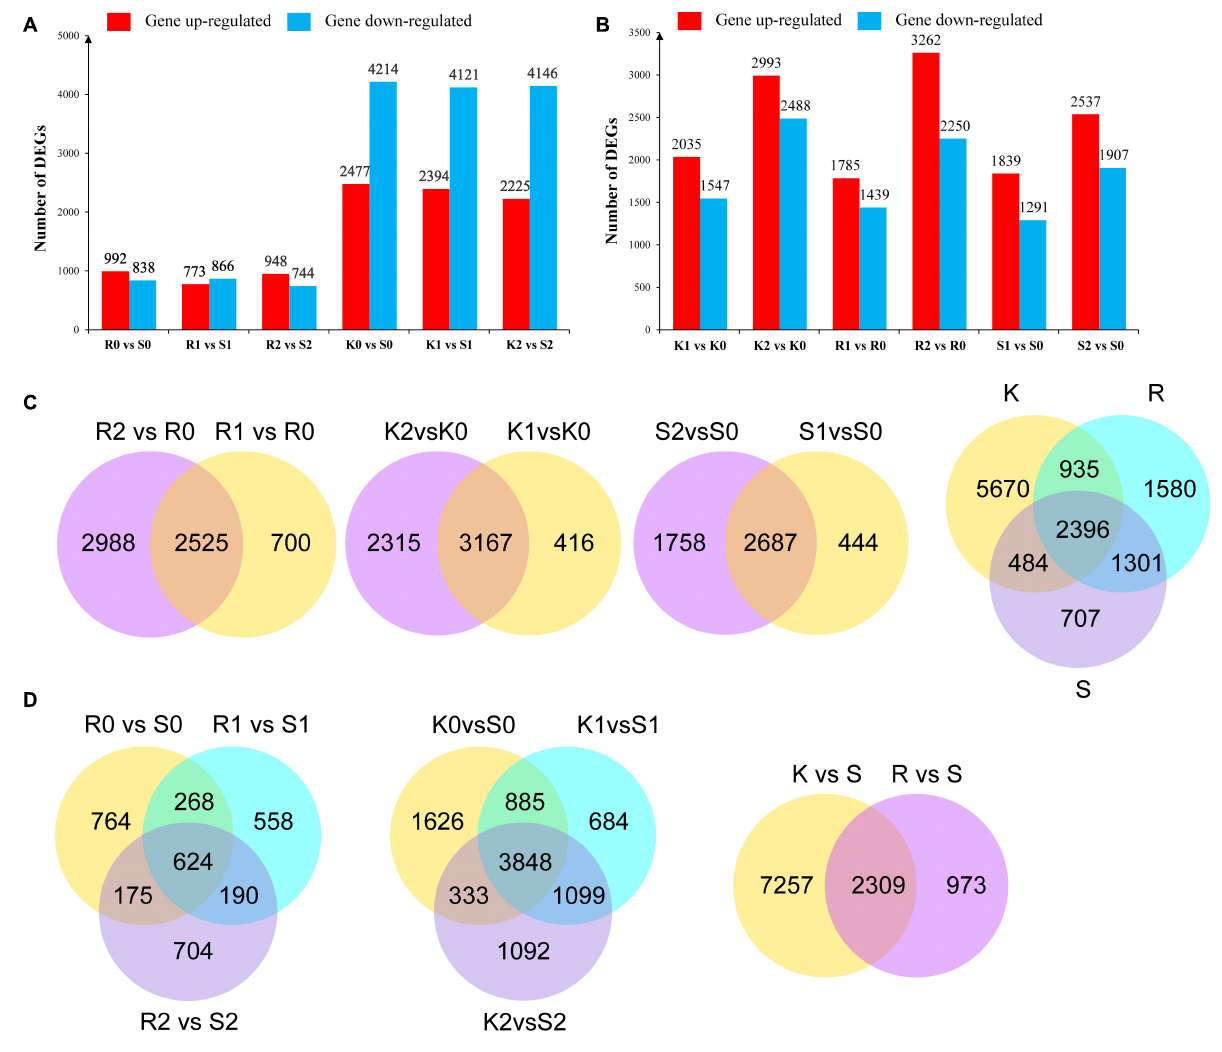
FIGURE 2 | Different expressed genes in different subgroups. (A) Differential genes up and down regulated after inoculation Xap of PI 319443, HR45 and Bilu. (B) Comparison of differential genes between genotypes. (C) Venn diagrams of DEGs of K/R/S at 0, 24, and 48 h time points after Xap inoculation. (D) Venn diagram of DEGs in response to resistant genotypes. Each box represents genes being up-regulated (red) and down-regulated